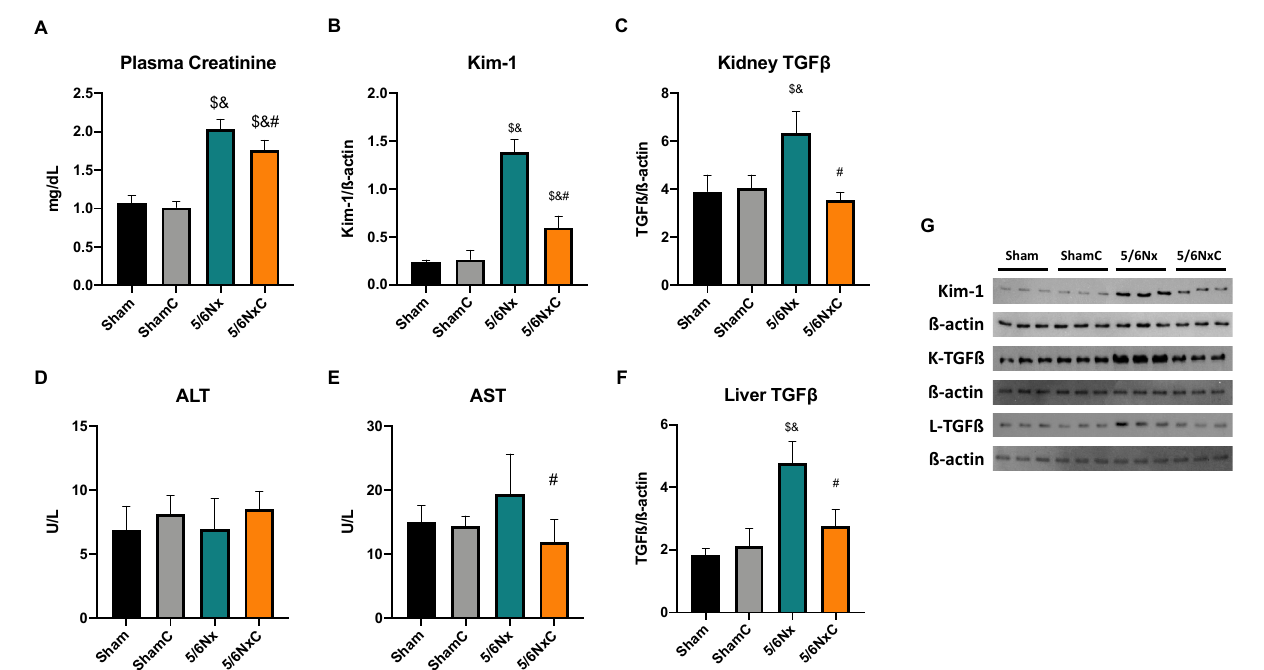
Figure 2. Kidney and liver damage markers in the four groups of rats studied: Sham, Sham + curcumin (ShamC), five-sixths nephrectomy (5/6Nx), and 5/6Nx + curcumin (5/6NxC). ( A ) Plasma creatinine (n = 11), ( B ) Kidney injury molecule-1 (Kim-1, n = 3), ( C ) Kidney transforming growth factor beta (TGF β , n = 3), ( D ) Plasma alanine aminotransferase (ALT, n = 11), ( E ) Plasma aspartate aminotransferase (AST, n = 11), ( F ) Liver TGF β (n = 3) and ( G ) representative images of western blot. β -actin was used as a loading control. One-way analysis of variance (ANOVA), post hoc Tukey, Mean ± SD. $ p < 0.05 vs. Sham, & p < 0.05 vs. ShamC, # p < 0.05 vs. 5/6Nx. K-TGF β = kidney TGF β and L-TGF β = liver TGF β .